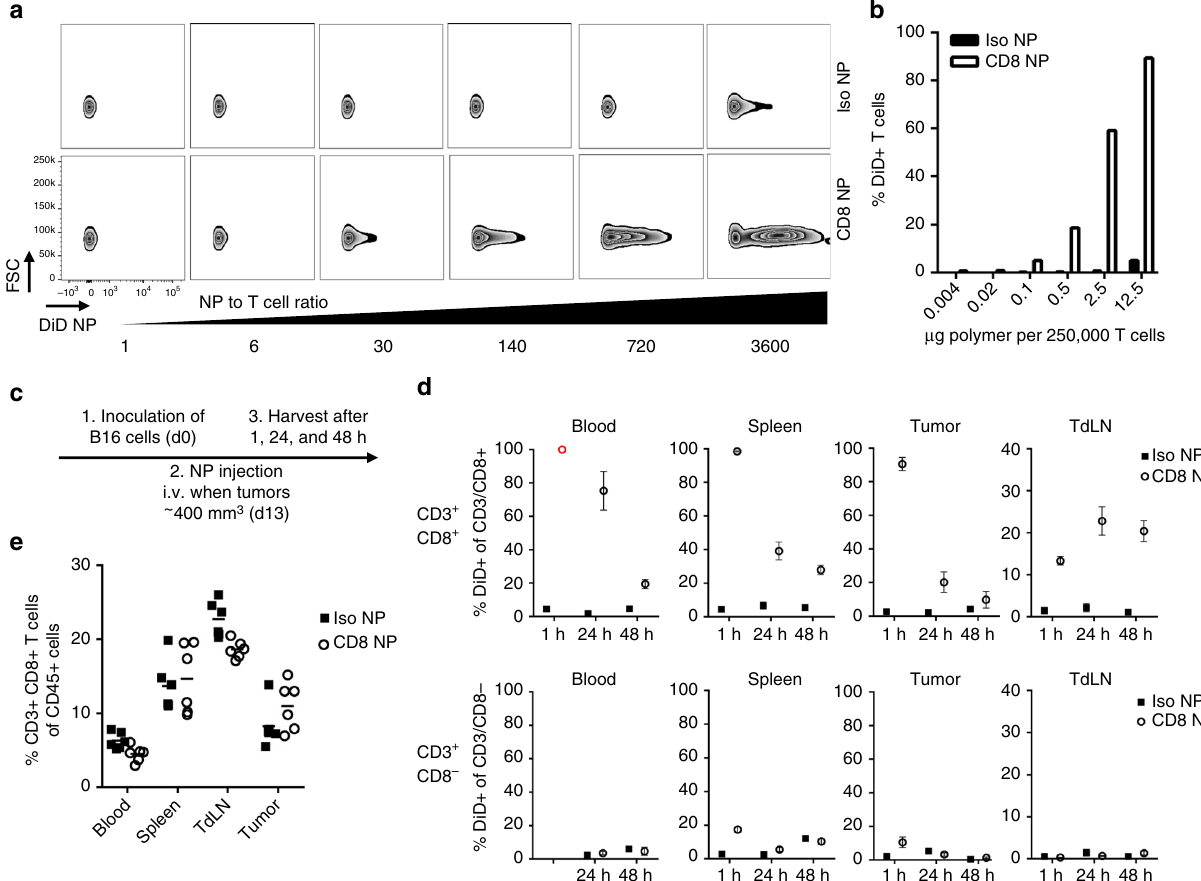
Fig. 2 CD8a-targeting nanoparticles bind to T cell in vitro and in vivo. a CD8a-targeting nanoparticles (loaded with DiD), but not isotype control nanoparticles, bind to the surface of CD8 + T cells isolated from the spleen within 30 min of incubation, as assessed by fl ow cytometry. b Quanti fi cation of DiD-positive T cells; data representative for more than 4 experiments. c Timeline of in vivo binding experiment. d Quanti fi cation of DiD-positive, CD3 + /CD8 + and CD3 + /CD8 − T cells 1, 24, and 48 h after the nanoparticles were injected intravenously; n = 3 for 1 and 48 h, n = 6 for 24 h, mean ± s.e.m.; (red open circle) Anti-CD8a antibody for fl ow cytometry staining could not bind due to steric hindrance with CD8a-targeting nanoparticles. e Quanti fi cation of CD3/CD8+ T cells in blood, spleen, tumor-draining lymph node (TdLN), and tumor 24 h after the nanoparticles were injected intravenously; n =